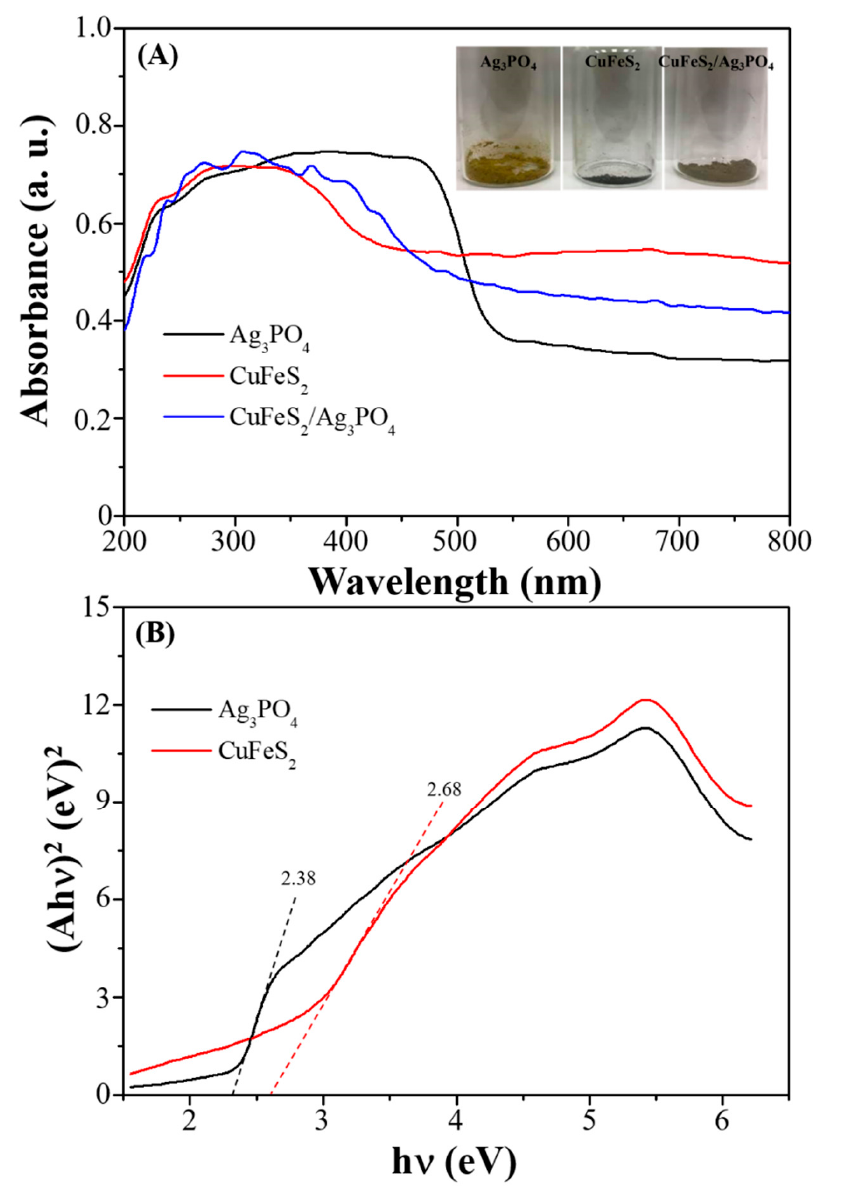
Figure 5. ( A ) UV–Vis diffuse reflectance spectroscopy (DRS) spectra and ( B ) Tauc’s plots of different samples: Ag 3 PO 4 (black), CuFeS 2 (red), and CuFeS 2 / Ag 3 PO 4 composites (blue).